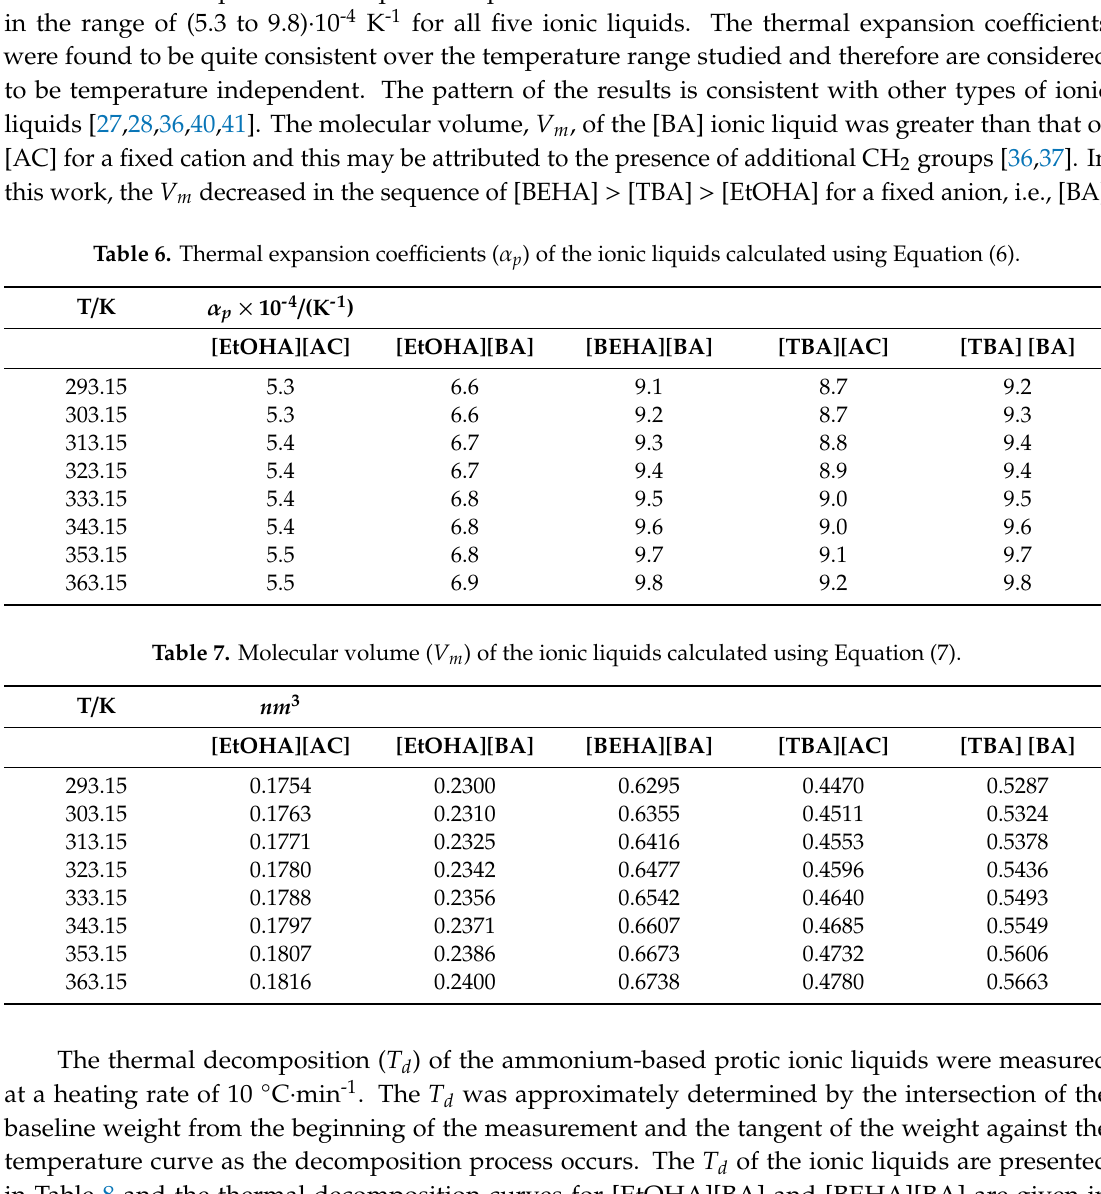
Figure 6. The thermal stability of the ammonium-based protic ionic liquids in this study varied with the ion combination. The T d of [BA] ionic liquid was higher than that of [AC] ionic liquid for